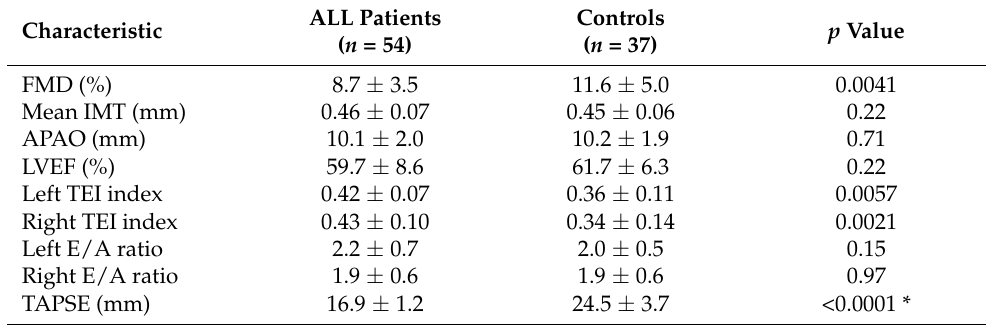
Table 2. Echocardiographic and vascular characteristics of the study population and controls.